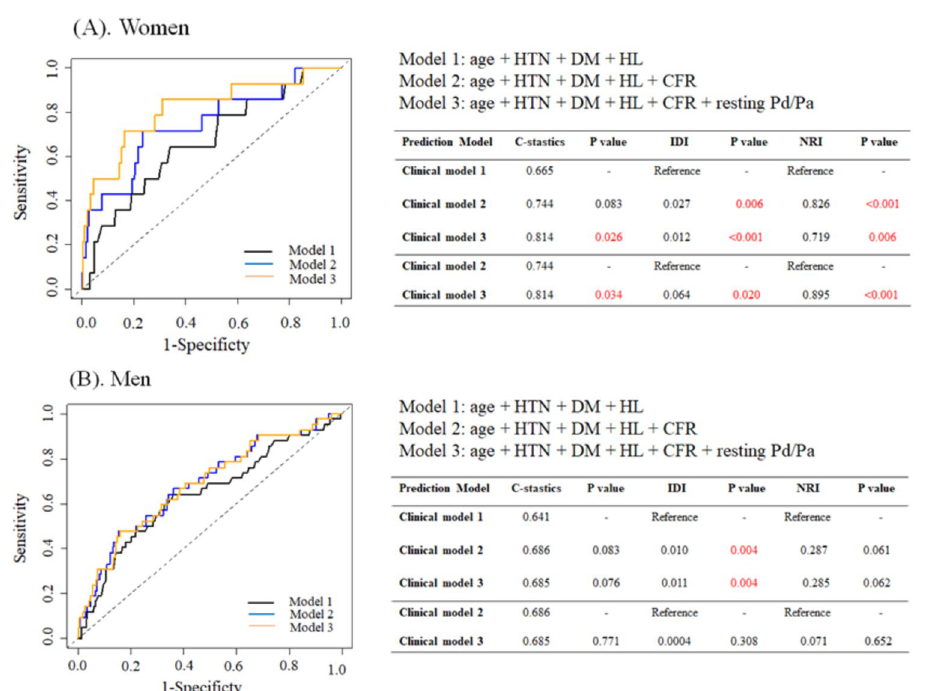
Figure 4. Comparison of ROC curves for clinical models to predict 2-year target vessel failure. The AUC of the ROC curve was improved by combining CFR and resting Pd/Pa in ( A ) women, whereas this trend was not seen in ( B ) men. ROC Receiver-operating characteristic, AUC Area under the curve. Other abbreviations are listed in Fig. 1 and Fig.